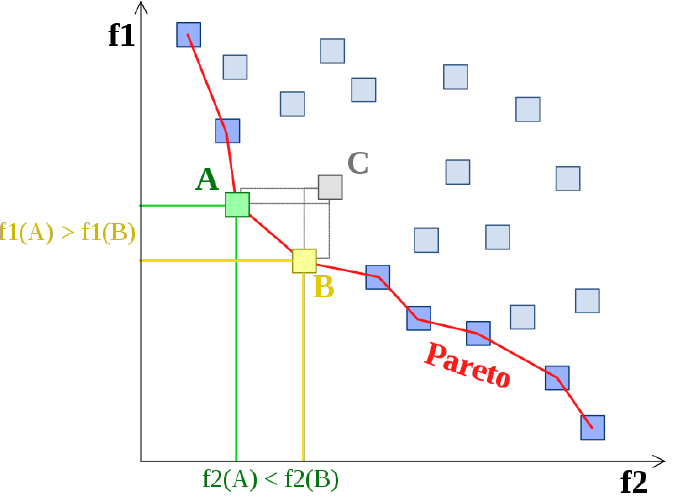
Figure 2. Example of Pareto front (in red), Point C is dominated by both points A and